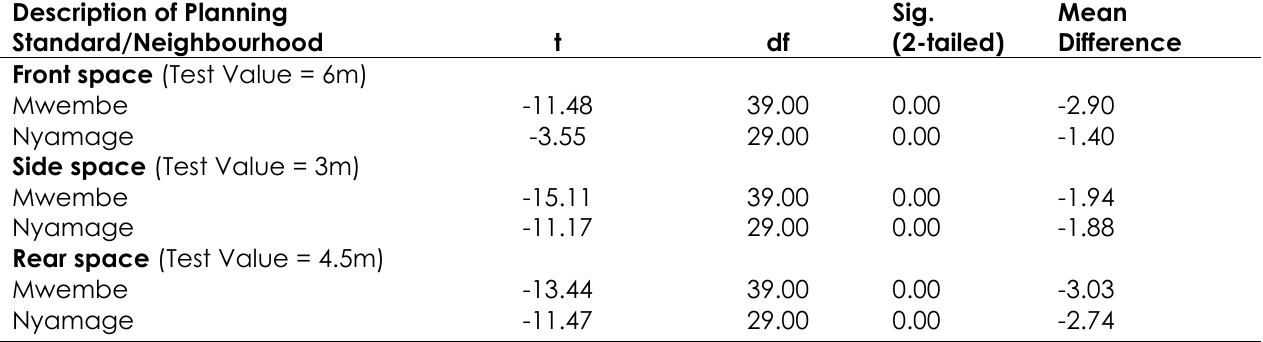
Table 5: One-sample test on compliance in Mwembe and Nyamage Description of